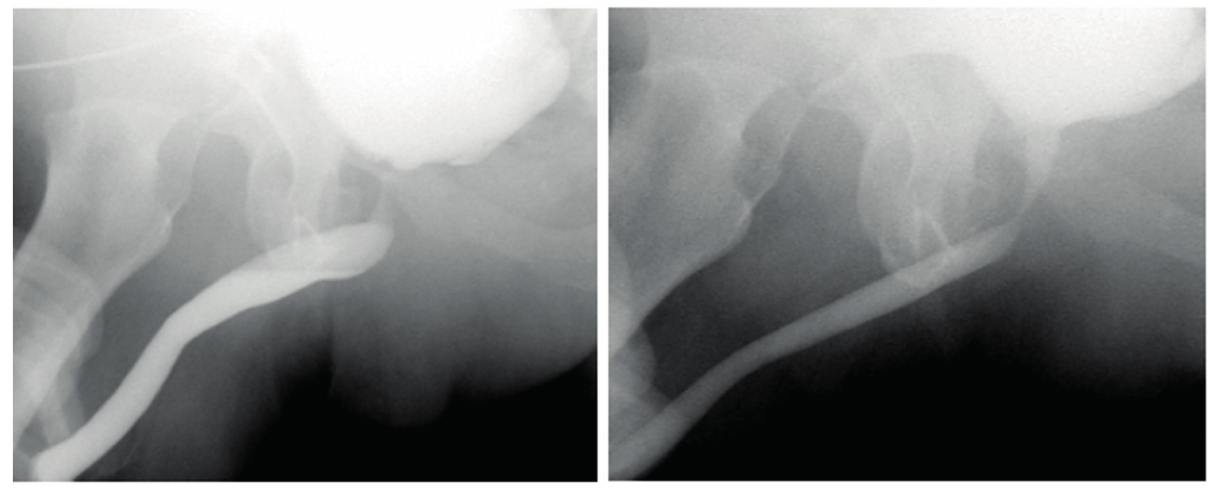
Figure 5 - Pre and post ORA cystourethrography in abdominal